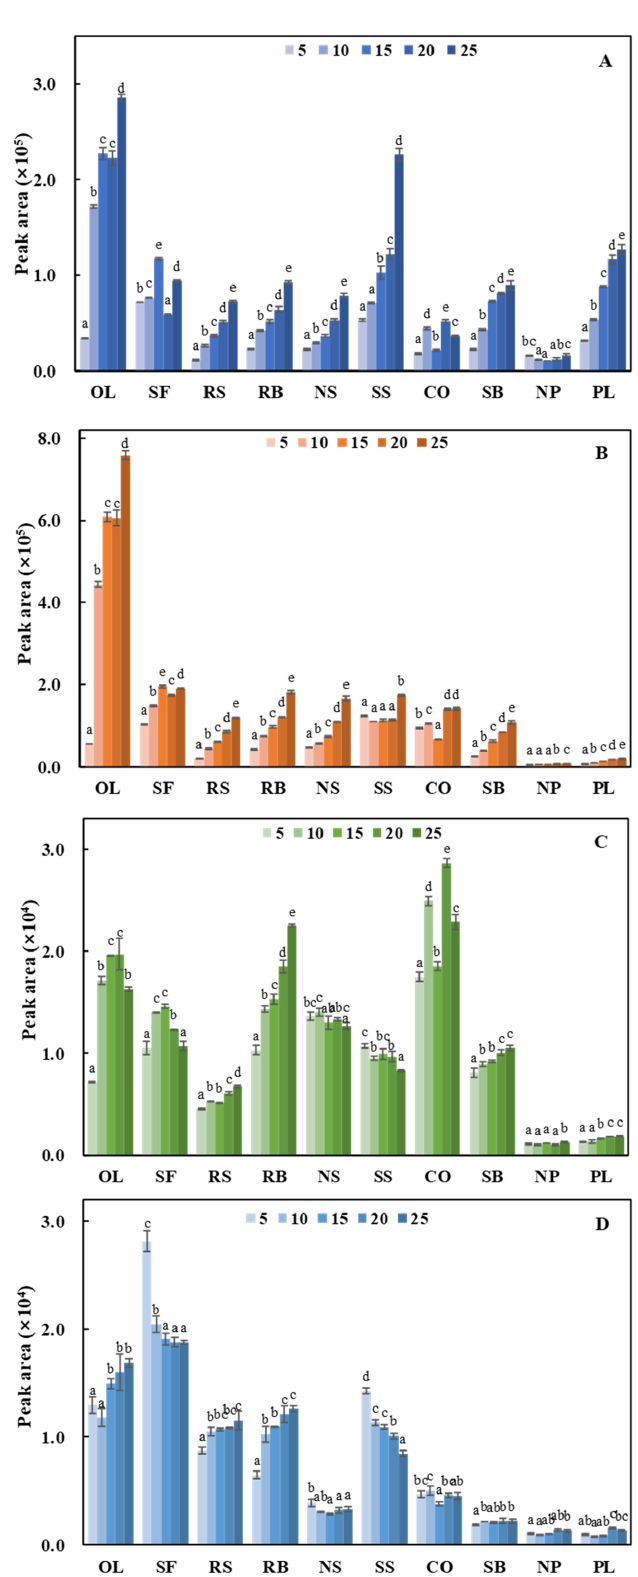
Figure 1. Variation in the peak area of the four volatile aldehydes common to all 10 oils with heating times from 5 to 25 h. ( A ) pentanal; ( B ) hexanal; ( C ) ( E )-hept-2-enal; ( D ) nonanal. The different lowercase letters mean that the variance of the same oil at different heating times is significant ( p < 0.05). Pentanal is generated by the oxidation of linoleic acid [29]. During the heating pro- cess, the peak areas of pentanal in 10 oils changed significantly, either gradually increas- ing or fluctuating (Figure 1A). Katragadda, et al. [30] also found that pentanal fluctuated in coconut, safflower, canola, and extra virgin olive oils during heating for 6 h. Also, this result is consistent with the previously published by Ben Hammouda, et al. [31], where pentanal either increased gradually (for pure olive pomace oil) or fluctuated (for the mix- ture of olive pomace oil and palm oil) during 60 consecutive deep fryings. The fluctuation